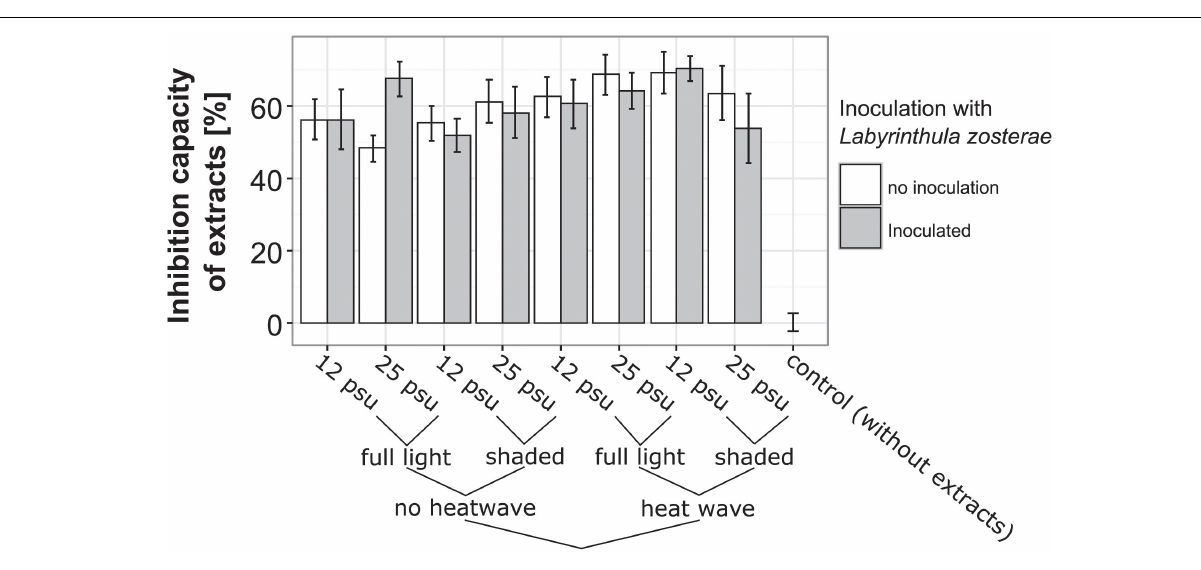
FIGURE 5 | Inhibition capacity of eelgrass extracts on Labyrinthula zosterae growth according to experimental treatments to which eelgrass shoots were exposed during the experiment. Control represents L. zosterae growth in liquid growth medium without eelgrass extracts. L. zosterae growth assays were performed for all treatments at 25 ◦ C in the dark for 14